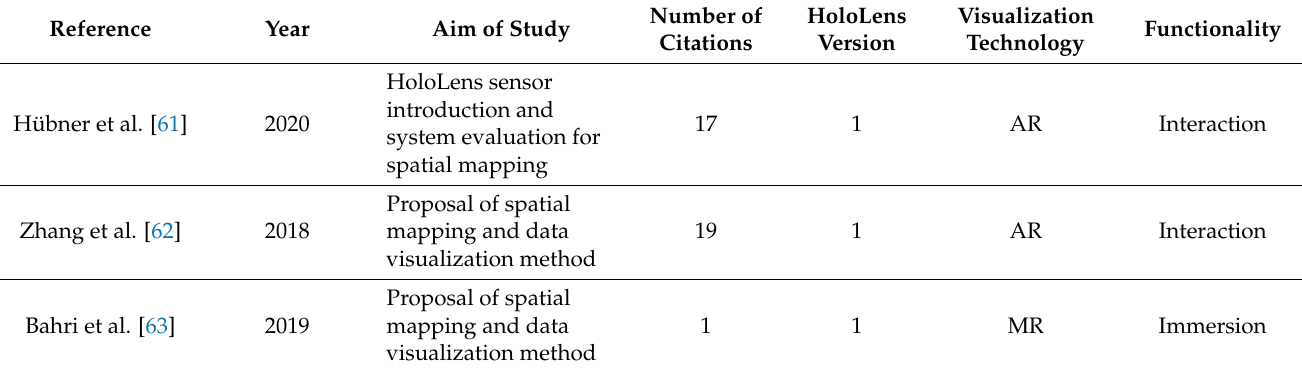
Table 5. Summary of Microsoft HoloLens application for architecture and civil